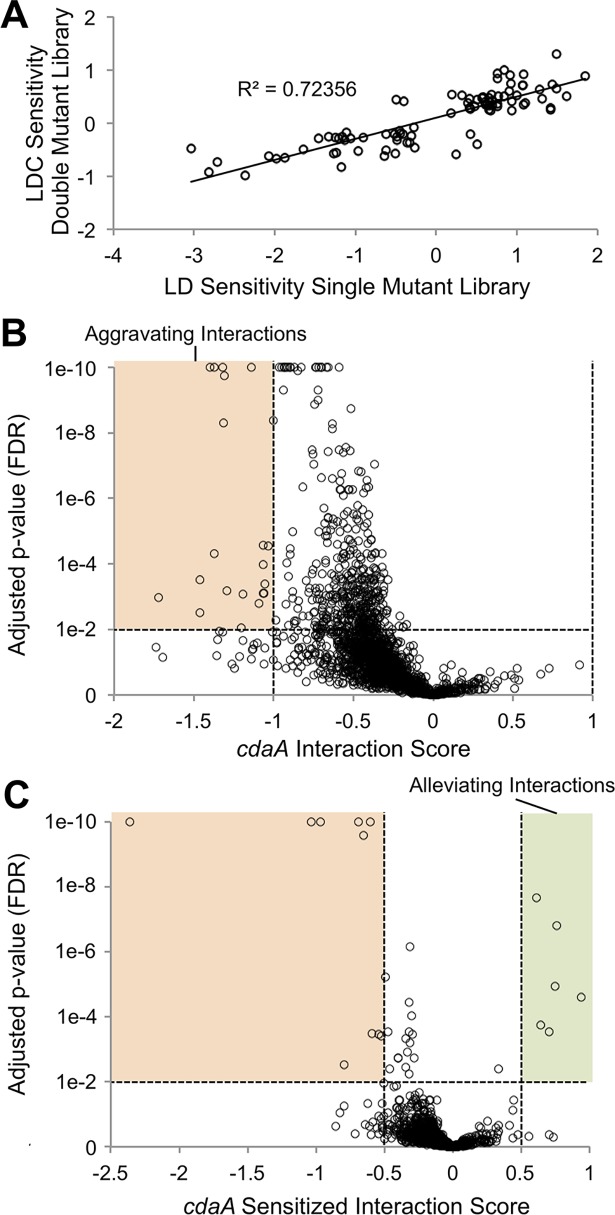
cdaA genetic interactions using IRB-Seq.(A) Validation of double-mutant screening by comparison to the previous single-mutant library LDC-sensitivity screen. Each circle represents a gene’s score for LDC sensitivity from a previously conducted screen of LDCs on the single-mutant library (x-axis), compared to a similar screen conducted here on a double-mutant library that carries a control mutation (y-axis). A linear regression analysis was used to determine correlation. (B and C) Plots of (B) genetic interactions and (C) LDC-sensitized genetic interaction of library genes with cdaA. Genes above the horizontal dashed line have FDR<0.01 (Linear mixed-effects model). Absolute values of interaction score thresholds of (B) 1 or (C) 0.5 are indicated by vertical dashed lines. All points with FDR<10−10 are plotted as FDR = 10−10.